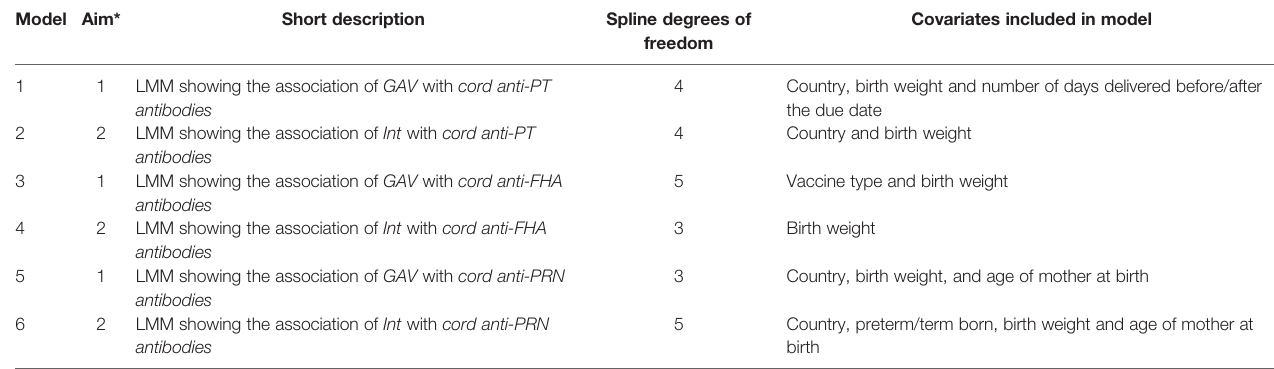
TABLE 4 | Overview of models. *Aim 1: effect of GAV on pertussis-speci fi c antibody titers at birth; Aim 2: effect of interval between GAV and GAD on pertussis-speci fi c antibody titers at birth. Model Aim*